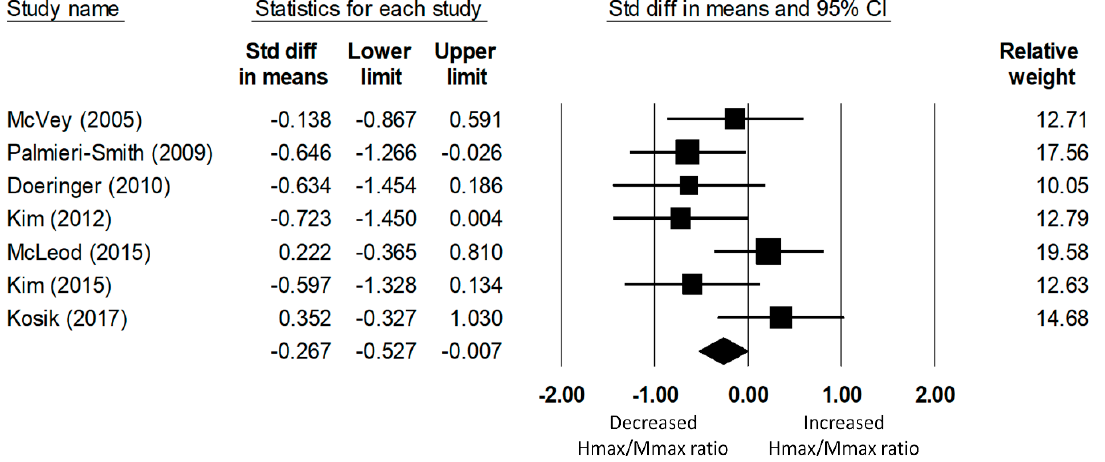
Figure 3. Forest plot illustrating Cohen’s d effect sizes for the fibular longus Hmax/Mmax ratio between groups with and without CAI and their 95% confidence intervals.